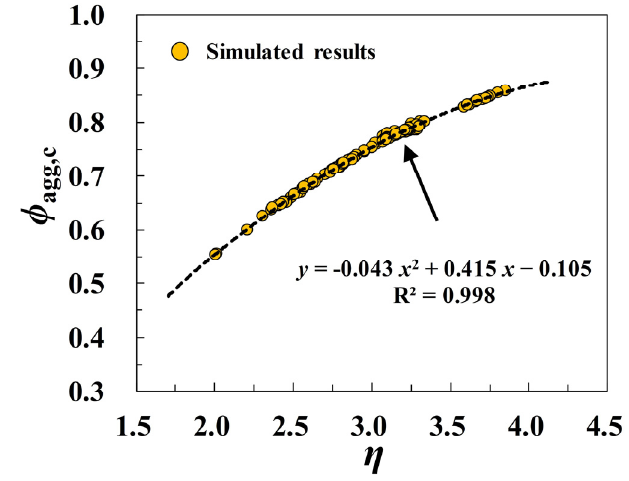
Figure 14. The variation of the critical percolation threshold ϕ agg,c as a function of the argument η .